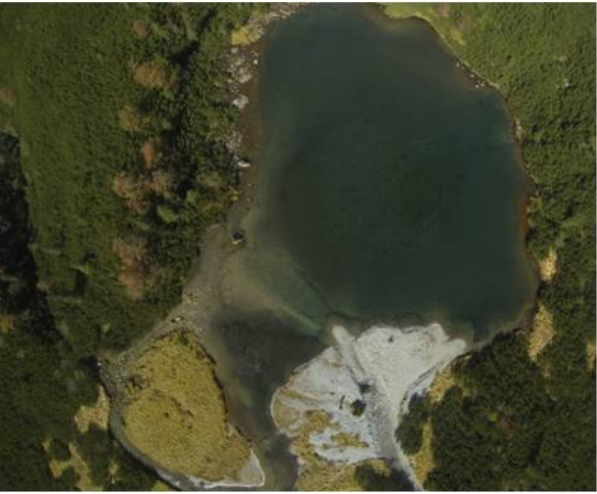
Figure 5. Quadrocopter photo – ˇ Cierne Javorové pleso alpine lake.